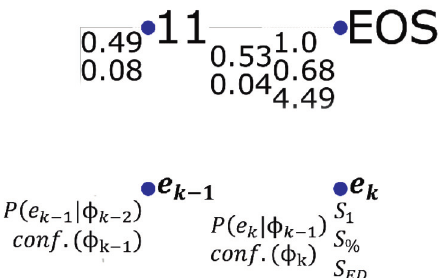
Figure 7: Explanation of the metrics located at the nodes of the probability tree.